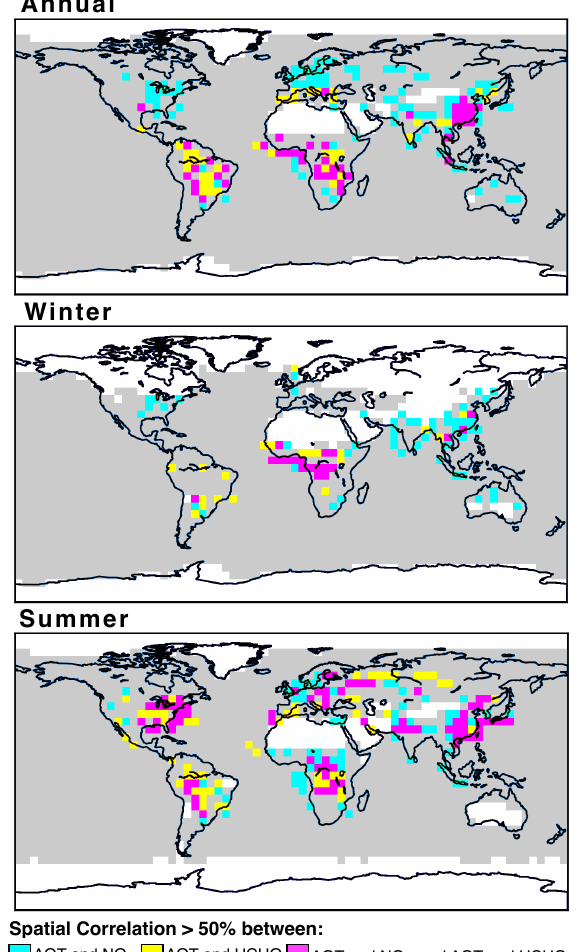
Fig. 6. Spatial correlation between AOT and NO 2 and HCHO for 5 × 5 ◦ grid boxes for the period 2005–2007. The colours in- dicate grid boxes where the spatial correlation between AOT and NO 2 and/or AOT and HCHO exceeds 50%. Grey is used for which the correlation was below 50%, or either NO 2 was below a thresh- old of 7 × 10 14 moleculescm − 2 or HCHO was below a threshold of 7 × 10 15 moleculescm − 2